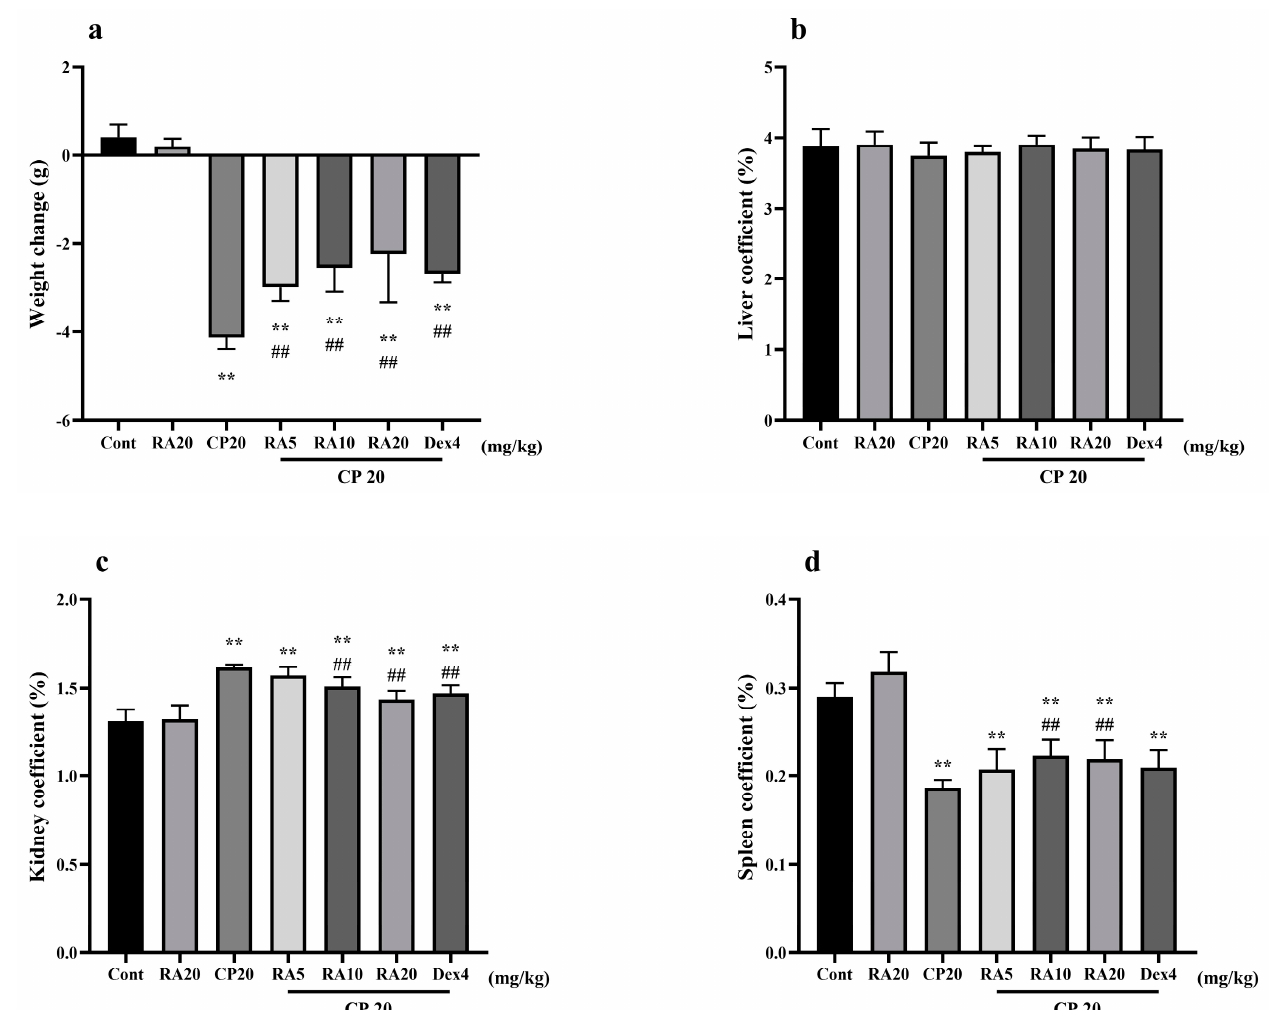
Figure 1. Effects of RA on body weight changes and organ indices in mice with CP − induced ALI and AKI. The body weight, liver, kidney, and spleen of mice were weighed, their body weight changes ( a ) are presented, and their liver coefficients ( b ), kidney coefficients ( c ), and spleen coefficients ( d ) were calculated. These experiments were repeated three times. ** and ## denote highly significant differences ( p < 0.01) compared with the control and CP model groups,